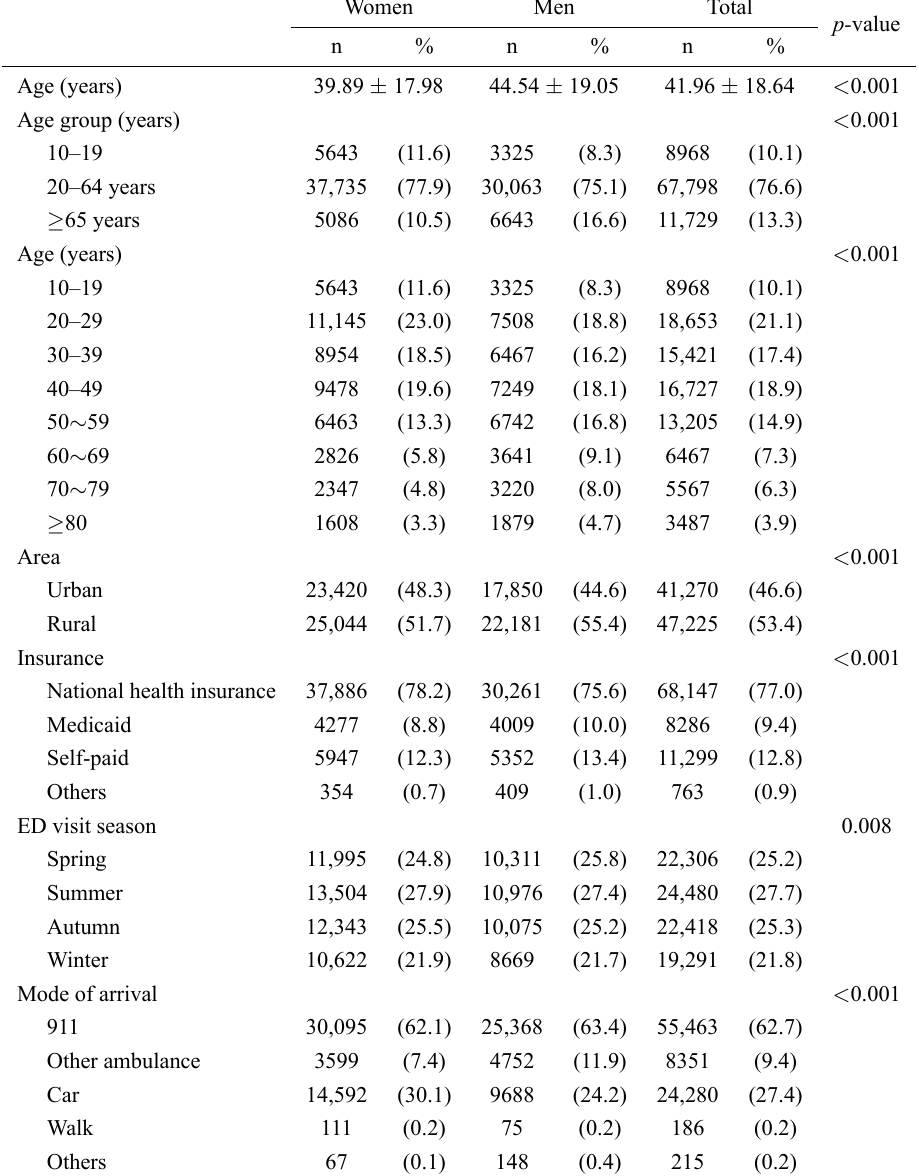
Table 1. Epidemiological characteristics of patients who were admitted emergency departments for suicide